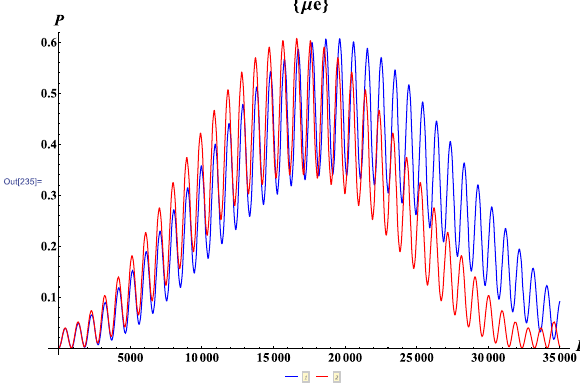
Fig. 1 Comparison of the oscillation probability from ν μ to ν e , com- puted (as a function of the baseline L) for neutrino energy E = 1GeV, inthe“standardtheory”(redcurve)andinpresenceofLIV(bluecurve), for LIV parameters δ f 32 = δ f 21 = 1 × 10 − 23